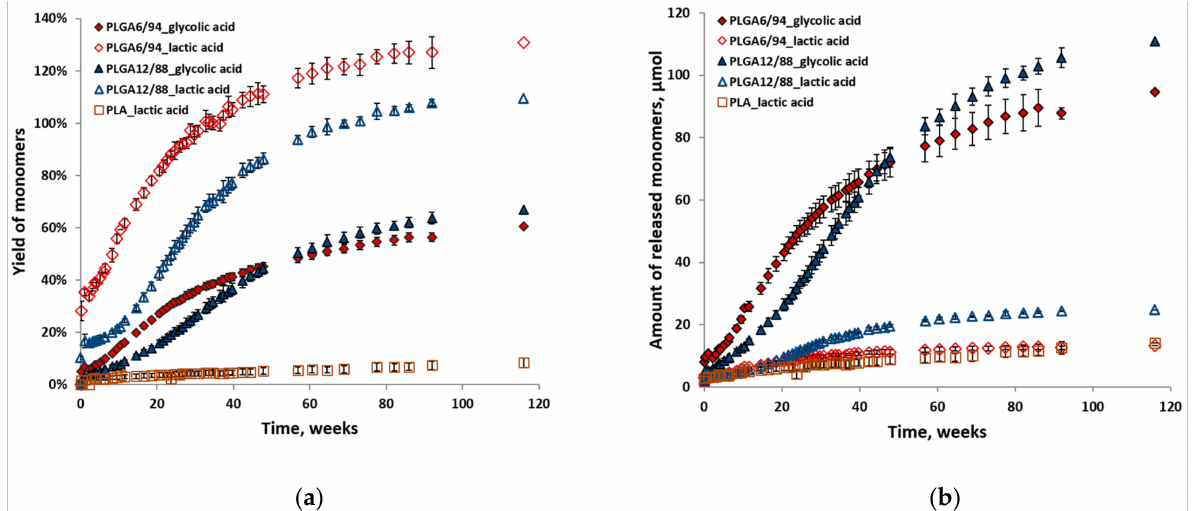
Figure 6. Individual yields ( a ) and amounts ( b ) of monomers (glycolic acid and lactic acid) versus time from hydrolysis of PLGA6/94, PLGA12/88 and PLA at 25 ◦ C in D 2 O. The points represent the averages of triplicate experiments, with the error bars representing the standard